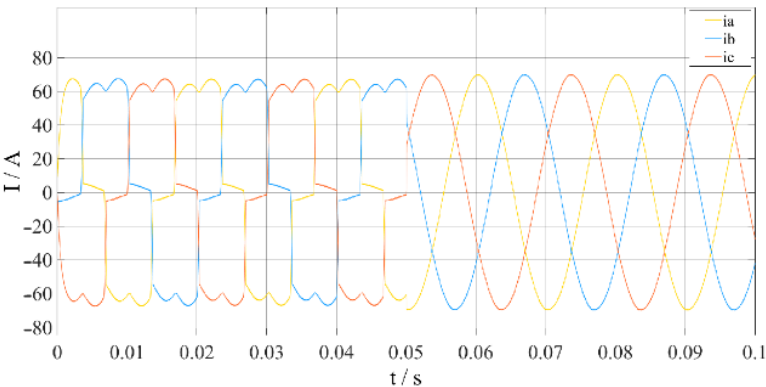
Figure 13. Mode 1 grid current diagram.